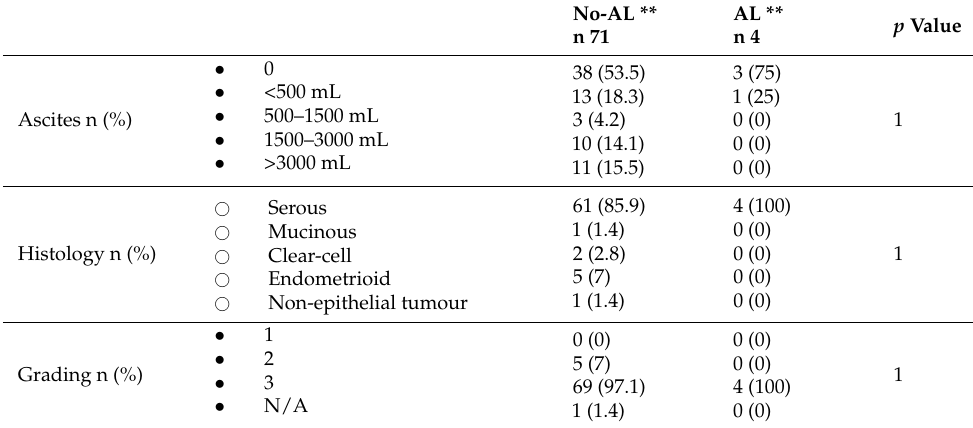
Table 6. Tumour and intraoperative characteristics analysis between no-AL and AL